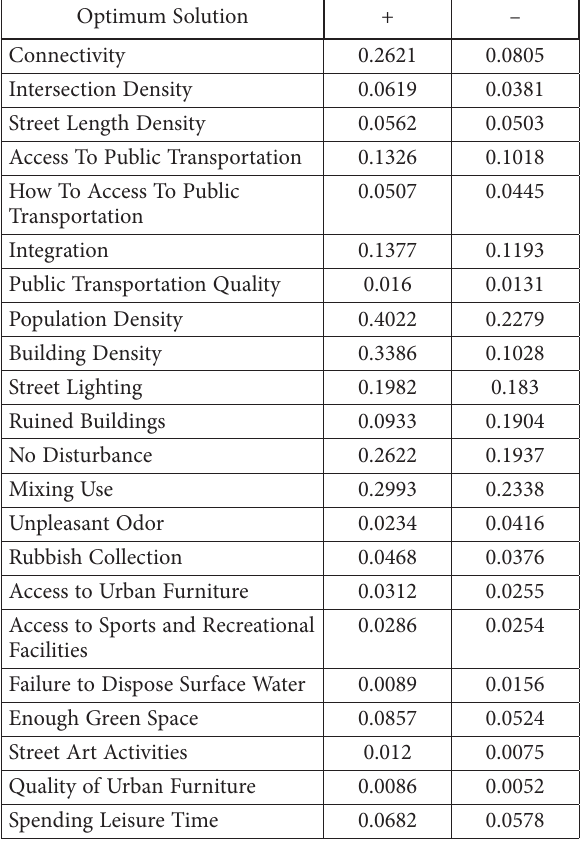
Table 9. Determining the optimum solution (source: authors)